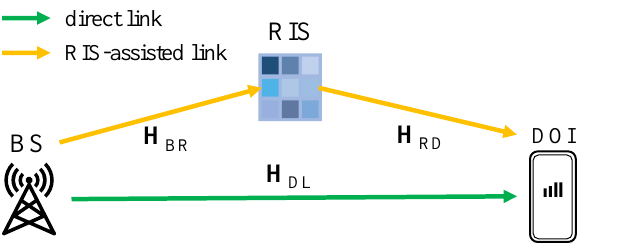
Figure 5. Path loss model in RIS-enhanced environments where the channel matrices H among the BS, the DOI, and the RIS are